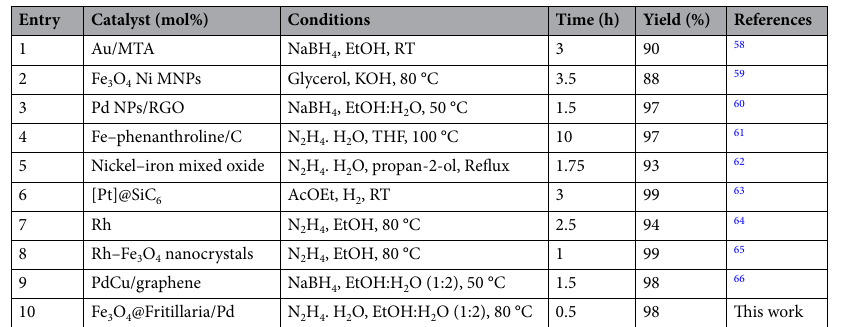
Table 3. Catalytic comparison in the reduction of